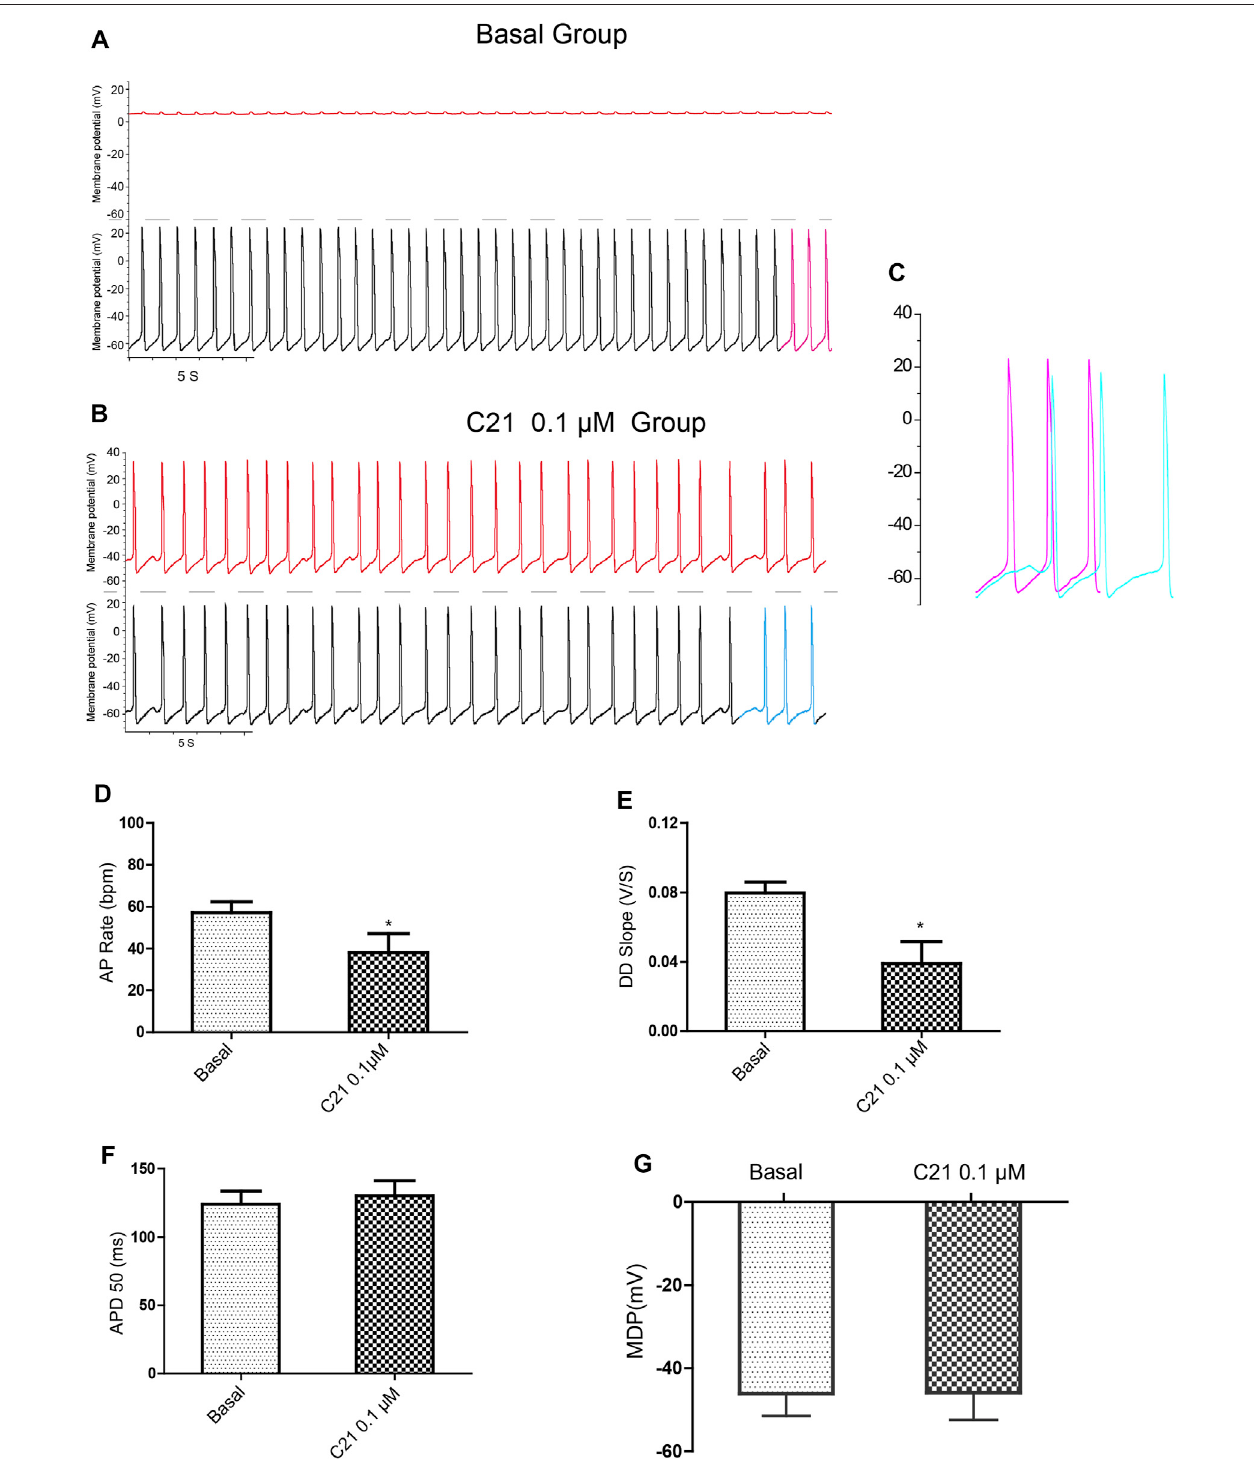
FIGURE 5 | Intracellular delivery of AT 2 R activator C21 decreased the APs of mESC-CMs. (A) Dual current patch clamp of APs of mESC-CMs without intracellular drug delivery (i.e., before membrane breakage by the “ drug electrode ” ). Upper panel represents recording in the “ drug electrode ” while the lower panel represents recording in the “ recording electrode. ” (B) Dual current patch clamp of APs of mESC-CMs with intracellular delivery of C21 (i.e., after membrane breakage by the “ drug electrode ” ).Upper panelrepresents recording inthe “ drugelectrode ” while thelowerpanelrepresentsrecordinginthe “ recording electrode. ” (C) Traceslabeled as pink in (A) (represents APs before intracellular C21 delivery) and as blue in (B) (represents APs after intracellular intracellular C21 delivery) are overlaid for comparison. (D – G) Summarized data on the (D) AP rate, (E) DD slope, (F) APD50, and (G) MDP of APs upon treatment with intracellular C21. Values are mean ± SEM of 6 – 10 independent experiments. * p < 0.05 vs. control